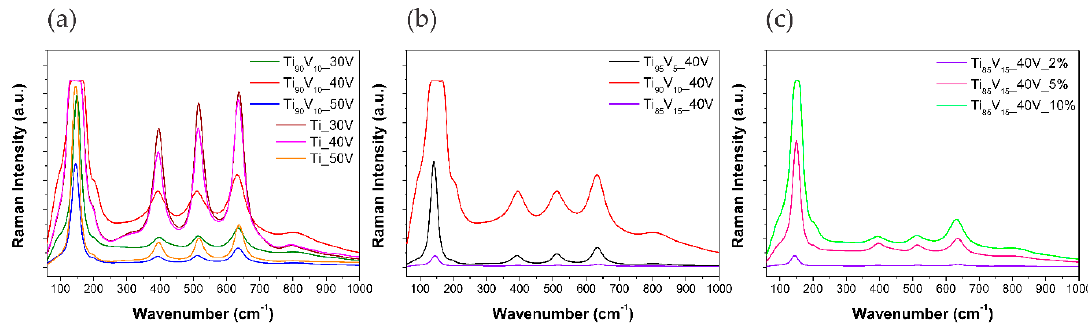
Figure 7. Raman spectra of pristine TiO 2 NTs and V 2 O 5 -TiO 2 NS. Effect of ( a ) anodization potential;